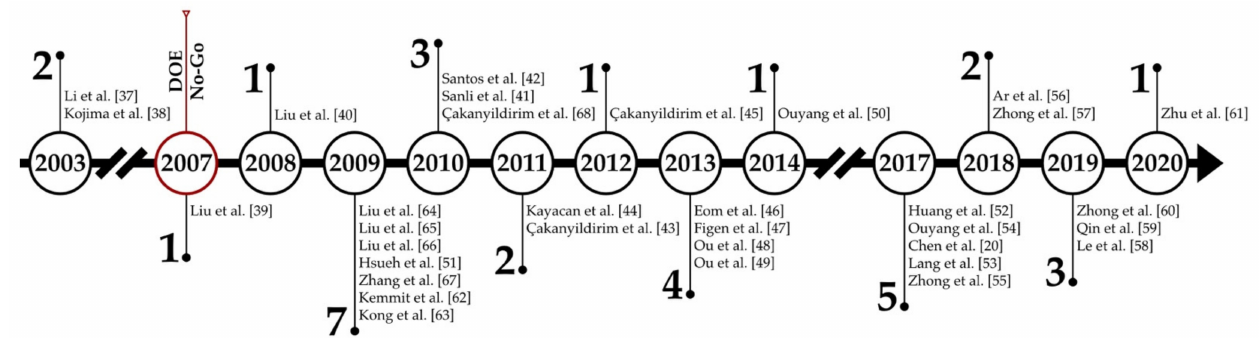
Figure 1. Timeline of published articles dedicated to NaBH 4 regeneration.